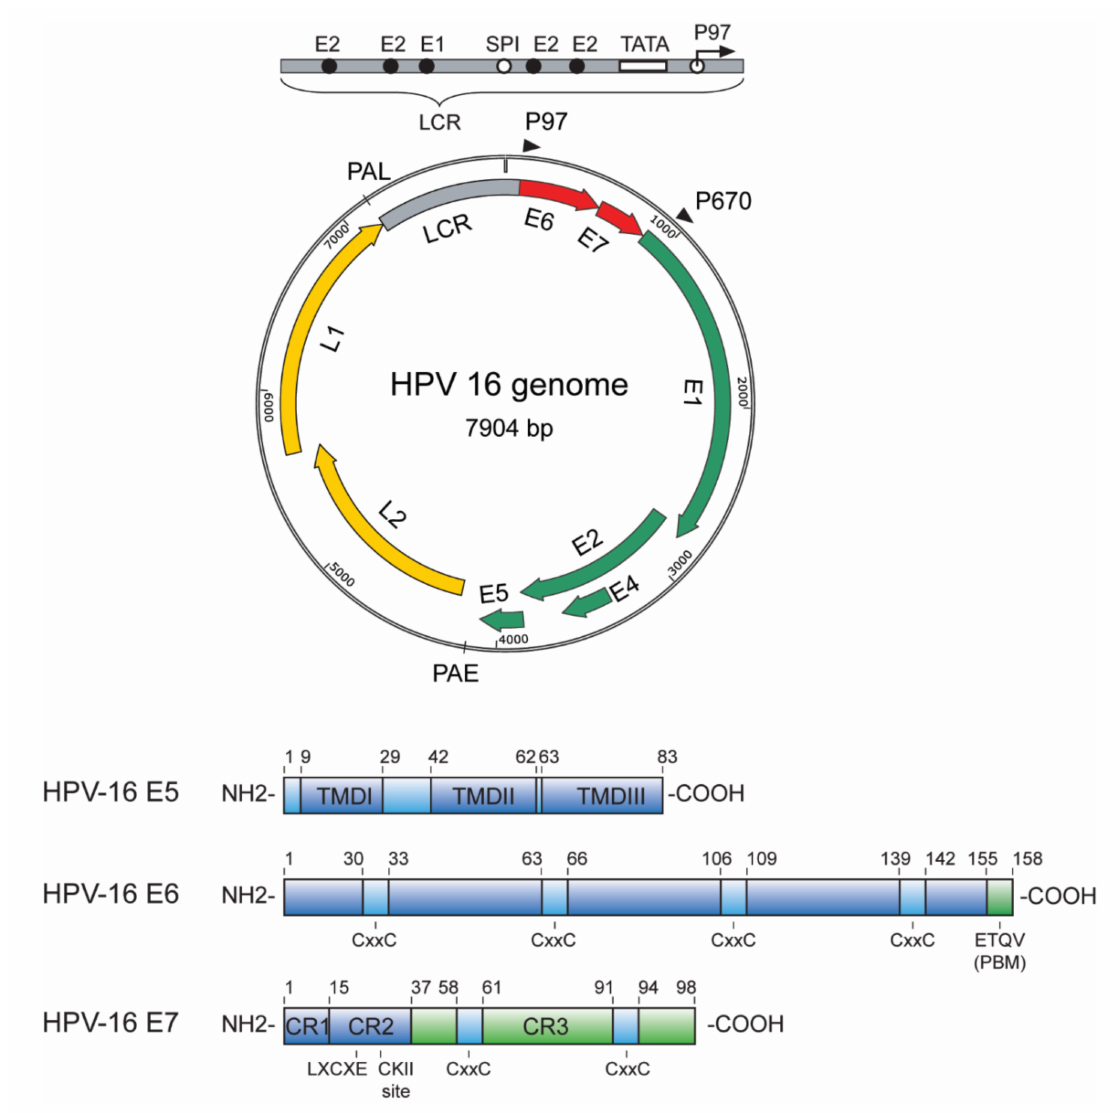
Figure 3. Schematic representation of HPV oncoproteins E5, E6 and E7. HPV16-E5 is an 83-amino acid-long transmembrane protein with three transmembrane domains (TMDI-III). HPV-16 E6 is an 158 amino acid protein with two CXXC (Cys- X-X-Cys,) motifs, which participate in coordinating with zinc ions and are indicated in the schematic. The C-terminus PDZ-binding motif (PBM) sequence ‘ETQV’ is shown, which can be phosphorylated by AKT, Chk2 via PKA and Chk1 kinases. HPV-16 E7 is a cytoplasmic phosphoprotein. The position of the conserved regions (CR1, CR2 and CR3) and CXXC (Cys-X-X-Cys) motifs, which participate in coordinating zinc ions, are also indicated. The LXCXE motif and CKII phosphorylation site in the CR2 region are important for targeting the pRB and related pocket